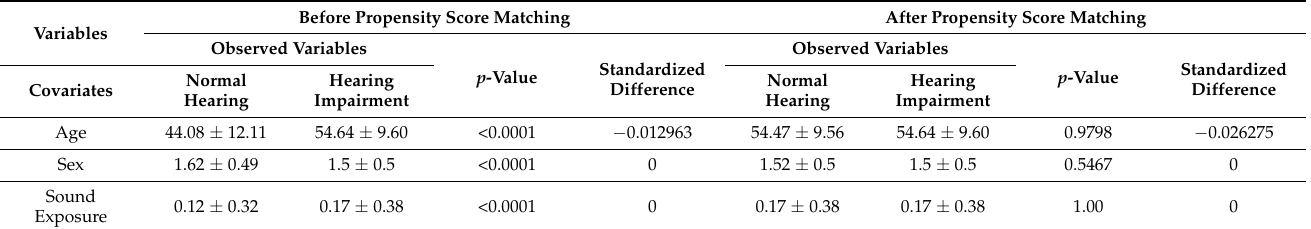
Table 3. Statistical analysis results and standardized differences before and after propensity score